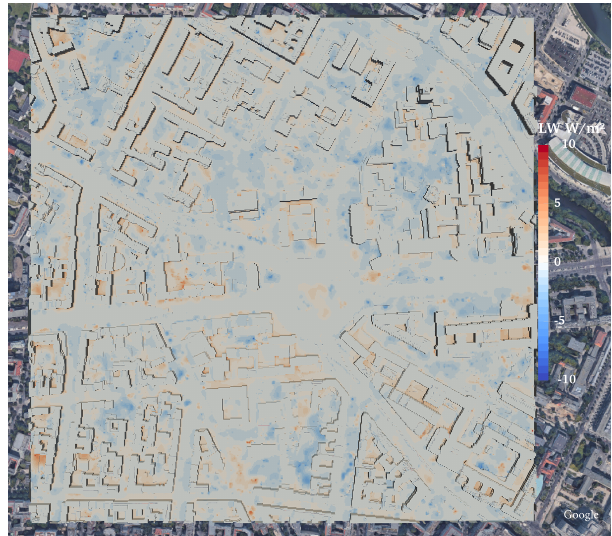
Figure 20. Changes in the received LW radiation flux for the re- alistic urban configuration at 12:00LST due to including multiple reflections (RTM_08). The copyright for the underlying satellite im- age is held by © GeoBasis-DE/BKG 2009, Google 2009.